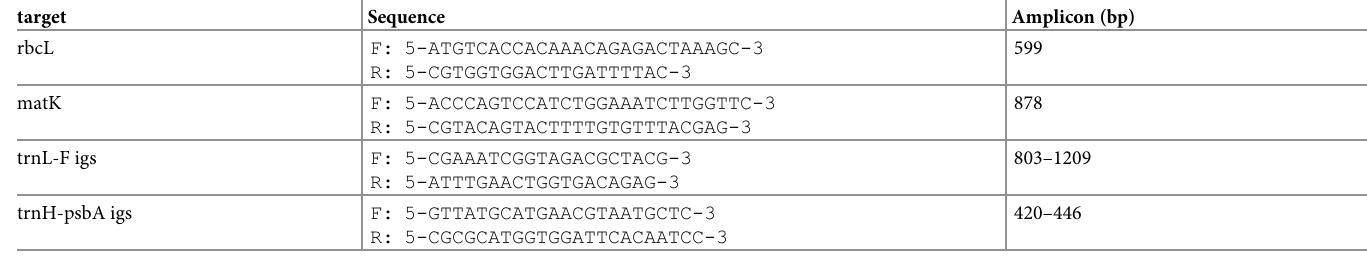
Table 2. Oligonucleotide primers used in the current study. Amplicon lengths are predicted for different Ocimum taxa investigated in the current study. target